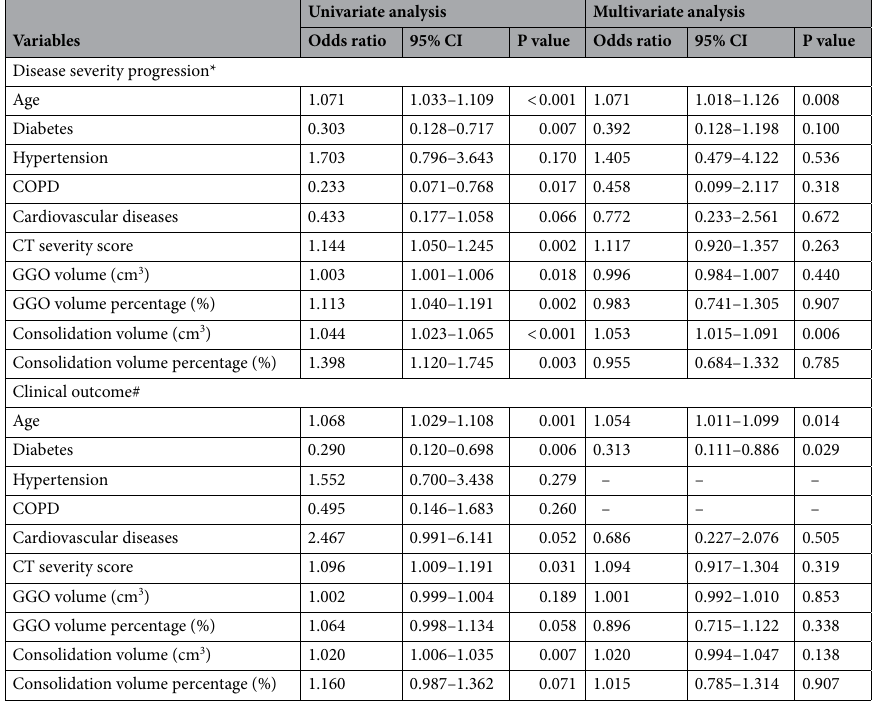
Table 4. Univariate and multivariate analysis of CT-derived parameters for prediction of disease severity progression and clinical outcome. AUC area under curve, CT computed tomography, CI confidence interval, COPD Chronic obstructive lung disease, GGO ground glass opacity, ROC receiver operating characteristic. *Disease severity progression was defined as the prediction of progress-to-severe group. # Clinical outcome was defined as the prediction of occurrence of critical events (a. respiratory failure and need mechanical assistance; b. shock; c. “extra pulmonary” organ failure, d. ICU